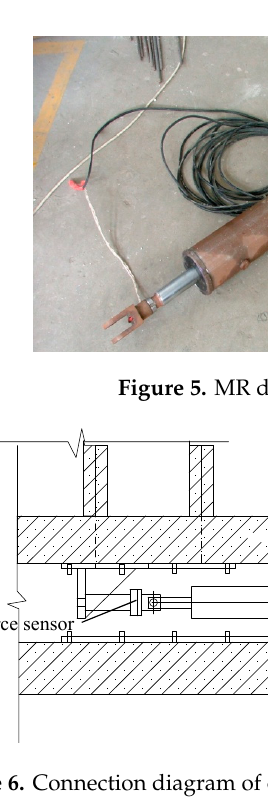
Figure 6. Connection diagram of damper in isolation layer.